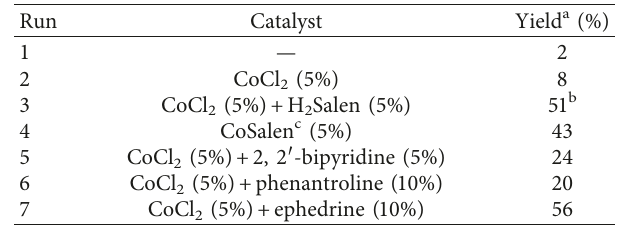
Table 4: Results of the reductive coupling reaction of 2-bro- mooctane with methylvinylketone with various anodes in an un- divided cell.